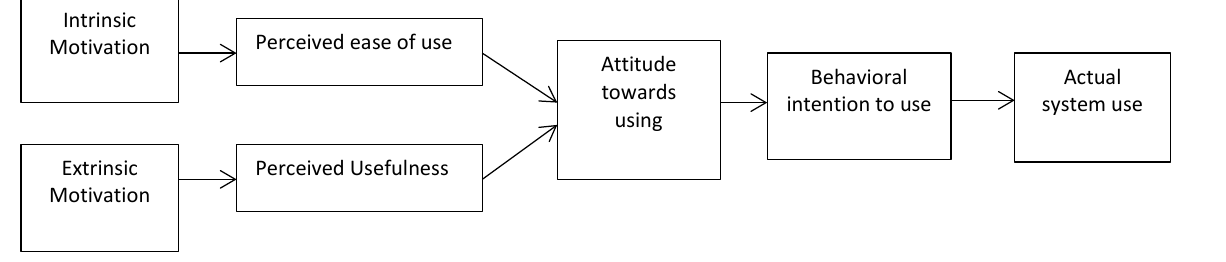
Figure 3. Effect of learner preference through digital